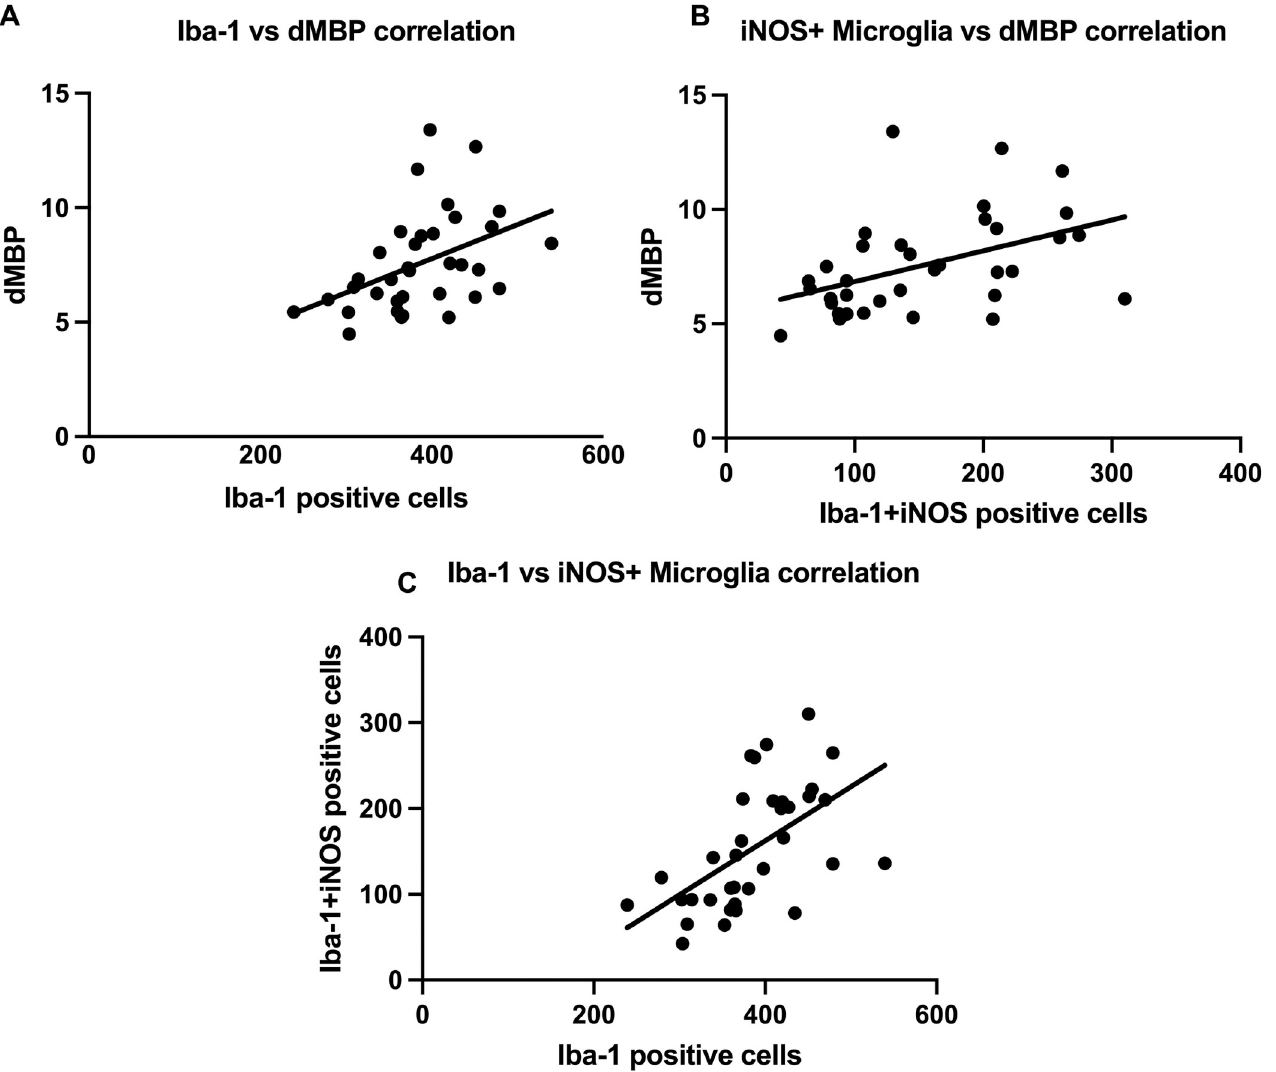
Fig 3. Microglial reactivity is correlated with myelin injury in the corpus callosum. (A) Iba-1 positive cell count was positively correlated with dMBP immunofluorescent density (r(33) = 0.438, p = 0.009). (B) iNOS-expressing microglia cell count was positively correlated with dMBP immunofluorescent density (r(33) = 0.445, p = 0.007). (C) Iba-1 positive cell count was positively correlated with iNOS-expressing microglia cell count (r(33) = 0.560, p <